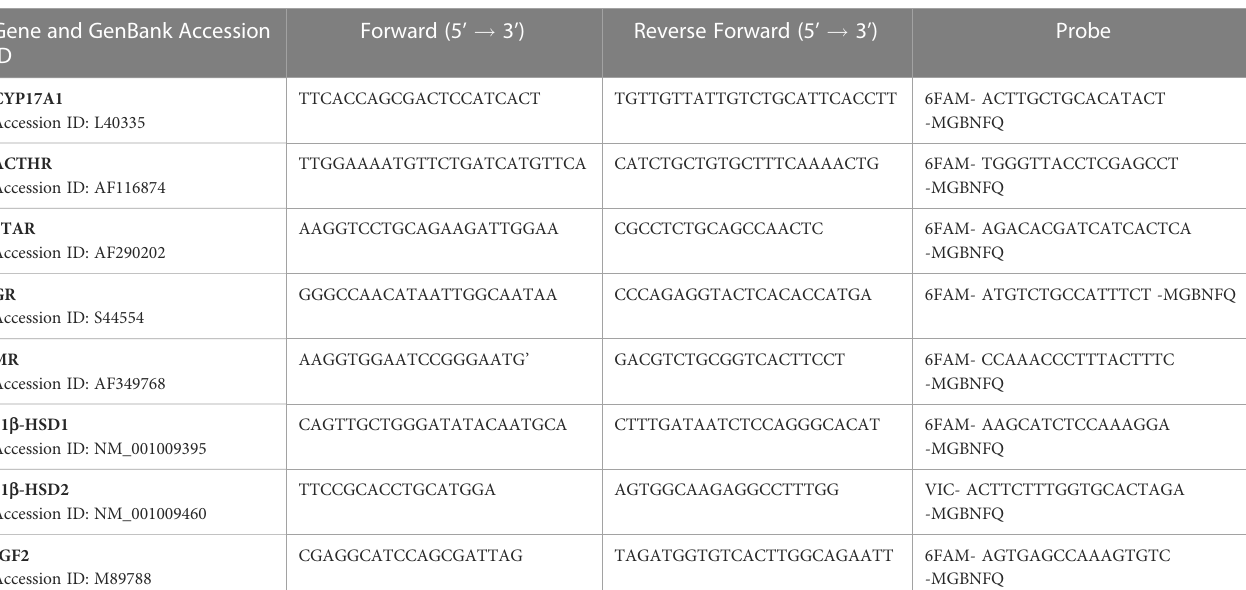
TABLE 1 Primer and probe sequences for target